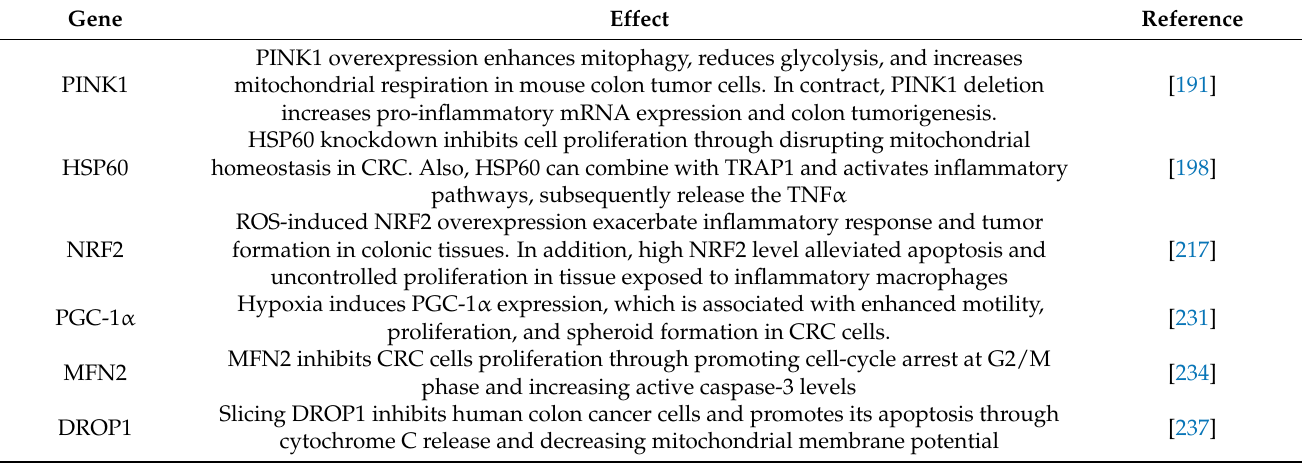
Table 2. The role of mitochondrial homeostasis related proteins in